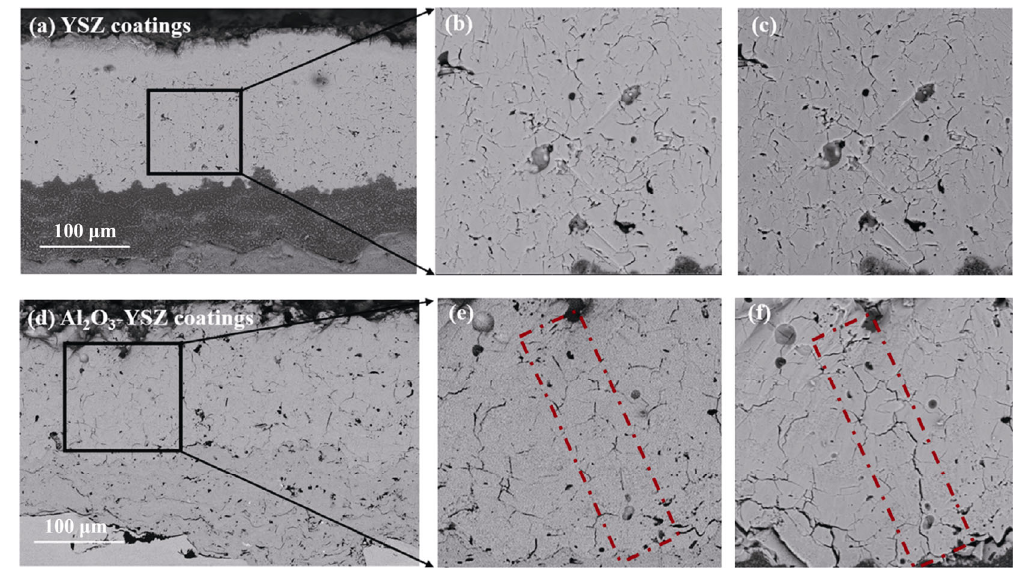
Fig. 4 SEM images of polished cross-sections of different coatings before and after thermal cycles: (a, b, d, e) before thermal cycles and (c, f) after five thermal